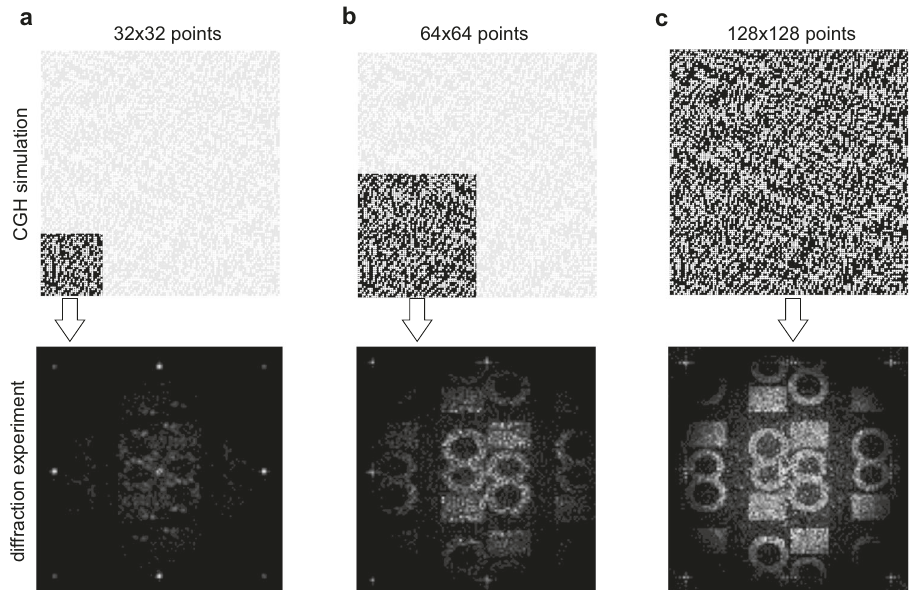
Fig. 6 | Progressing writing of holographic points. CGH pattern (top panel) and reconstructed far- fi eld diffraction images during progressing writing of a 32×32, b 64×64, c 128×128 holographic